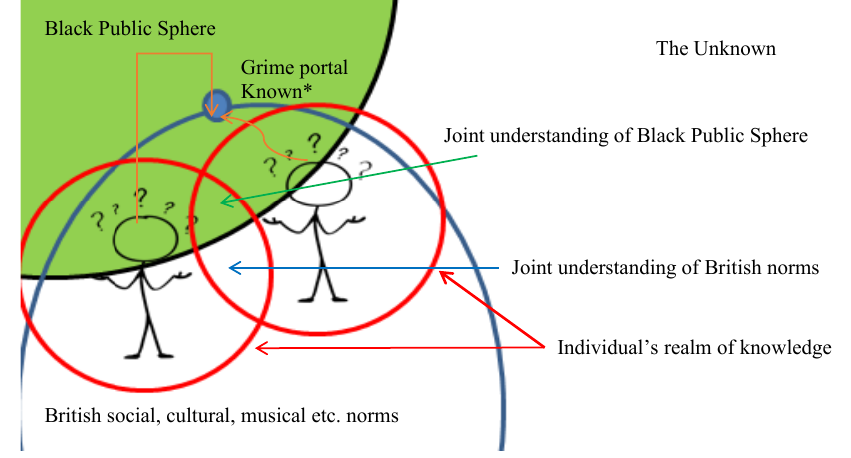
Figure 2. Scene Based, Making Music and